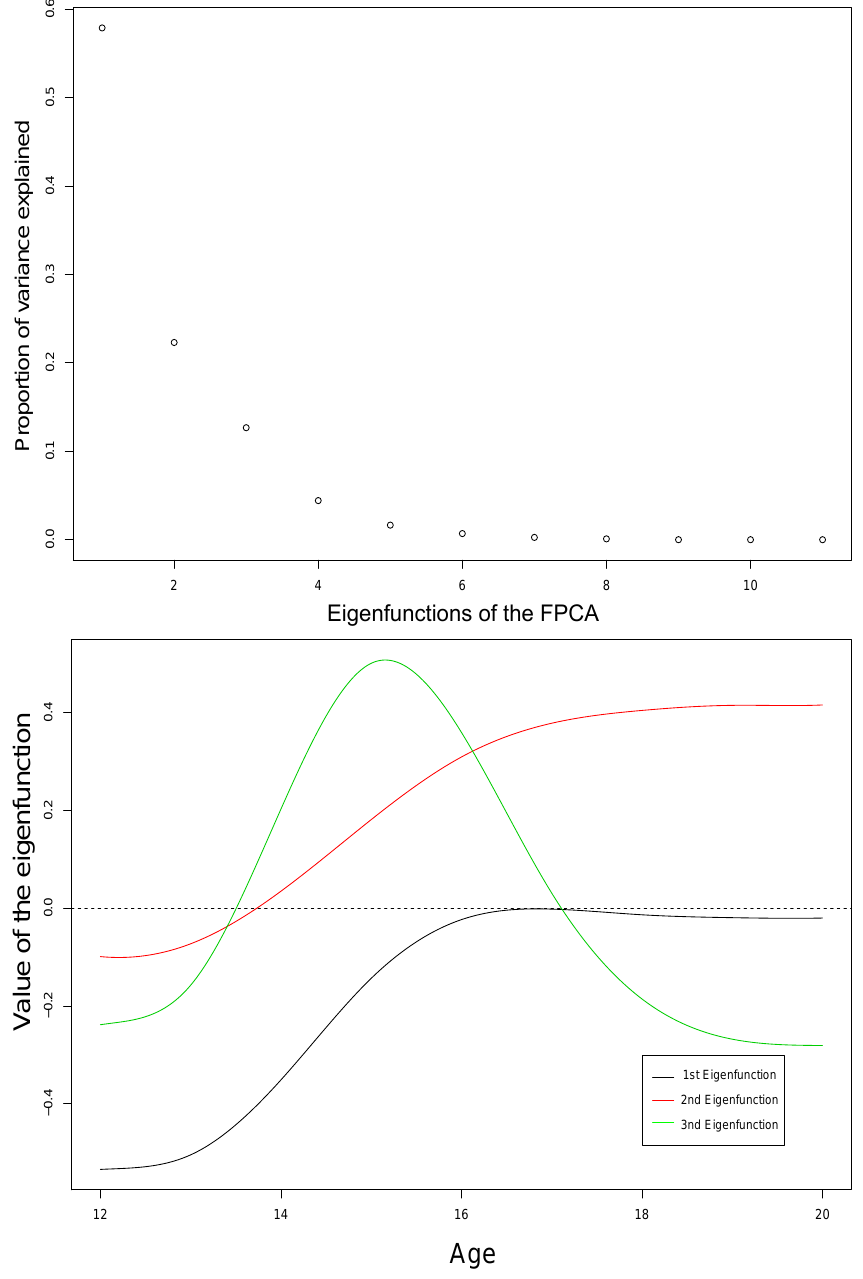
Figure A2. Results of the FPCA on the derivatives of the progression curves. ( Top ) proportion of variance explained by each eigenfunction. With only three eigenfunctions, one can express about 90% of the total variance of the data set; ( Bottom ) values of the three first eigenfunctions. Eigenfunctions are orthogonal to each other and display the main modes of variation of the curves. The first eigenfunction mainly informs about derivative differences at young ages, while the second focuses on the behaviour between 16 and 18 years old. The third eigenfunction expresses the differences of swimmers improvement between the middle and the bounds of the time